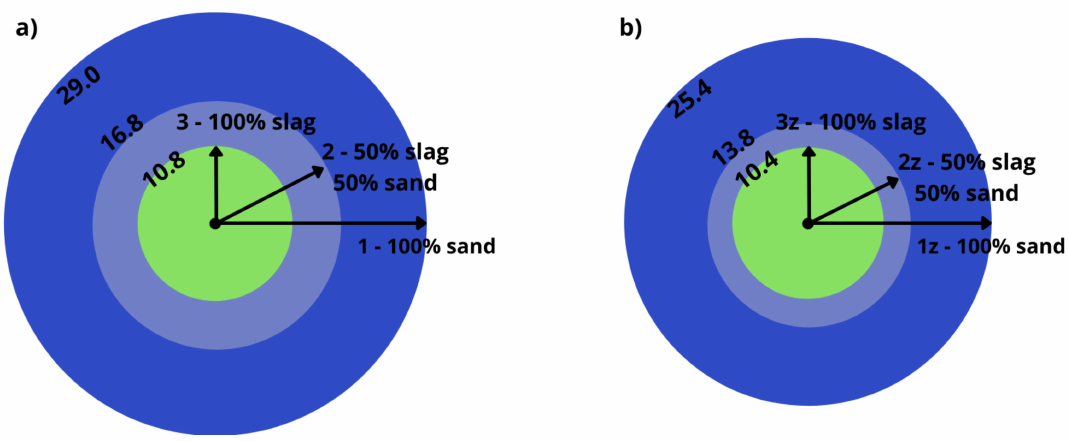
Figure 5. Consistency of fresh mortars based on sand and slag, with ( b ) and without ( a ) zeolite shown as the spreading diameter (cm) of the